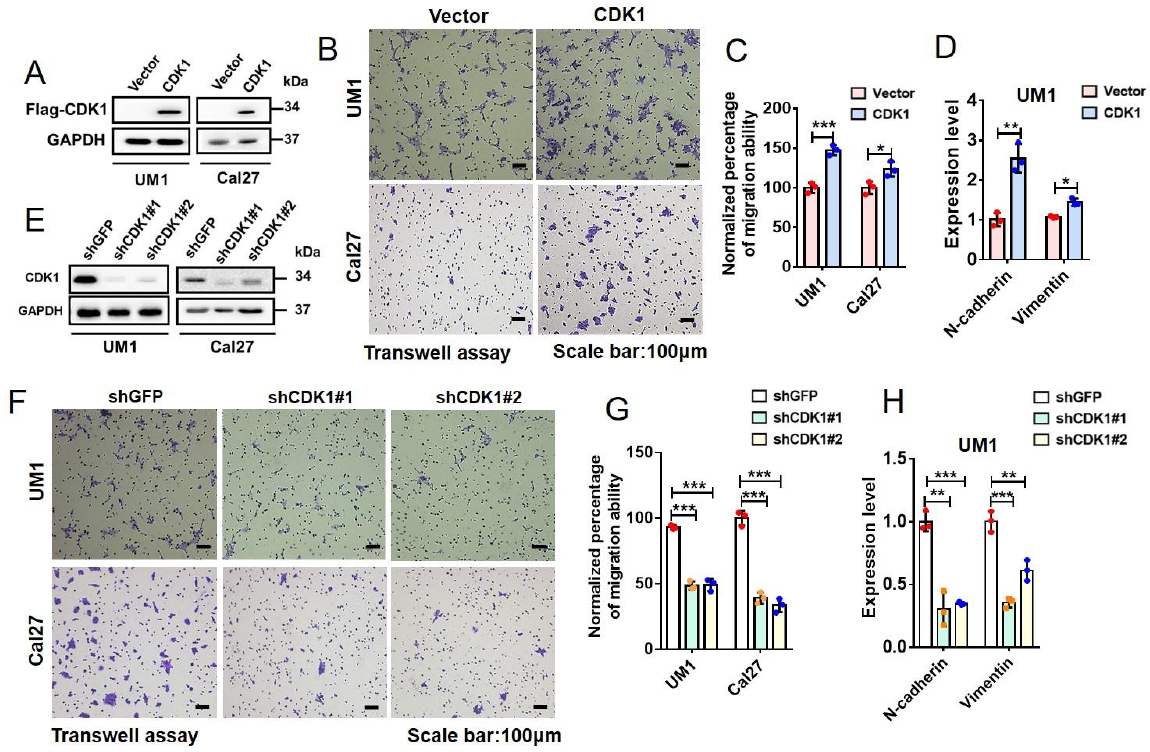
Figure 5. CDK1 promotes epithelial-mesenchymal transition (EMT) and migration of HNSCC cells. ( A , E ) CDK1 was overexpressed or knocked down in UM1 or Cal27 cells with lentiviral infection, and the resultant stable cell lines were identified by means of IB analysis. ( B , F ) Indicated stable cells were subjected to transwell assay. Representative crystal violet staining images of migrated cells on the underside were shown. ( C , G ) Quantification of effects of CDK1 overexpression or knockdown on migration ability based on transwell assays (means ± SD, n = 3). *** , p < 0.001; *, p < 0.05. ( D , H ) UM1 cell lines with CDK1 overexpression or knockdown were subjected to RT - qPCR analysis to measure mRNA levels of N-cadherin and vimentin (normalized with GAPDH). The qPCR data were presented as means ± SD (n = 3). *** , p < 0.001; ** , p < 0.01; * , p < 0.05.